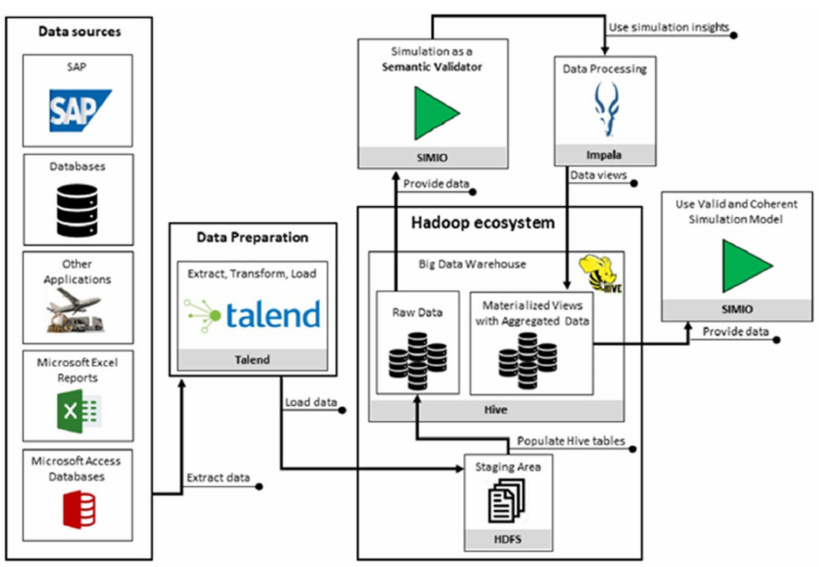
Figure 2. Steps required to provide semantically valid data to the simulation model